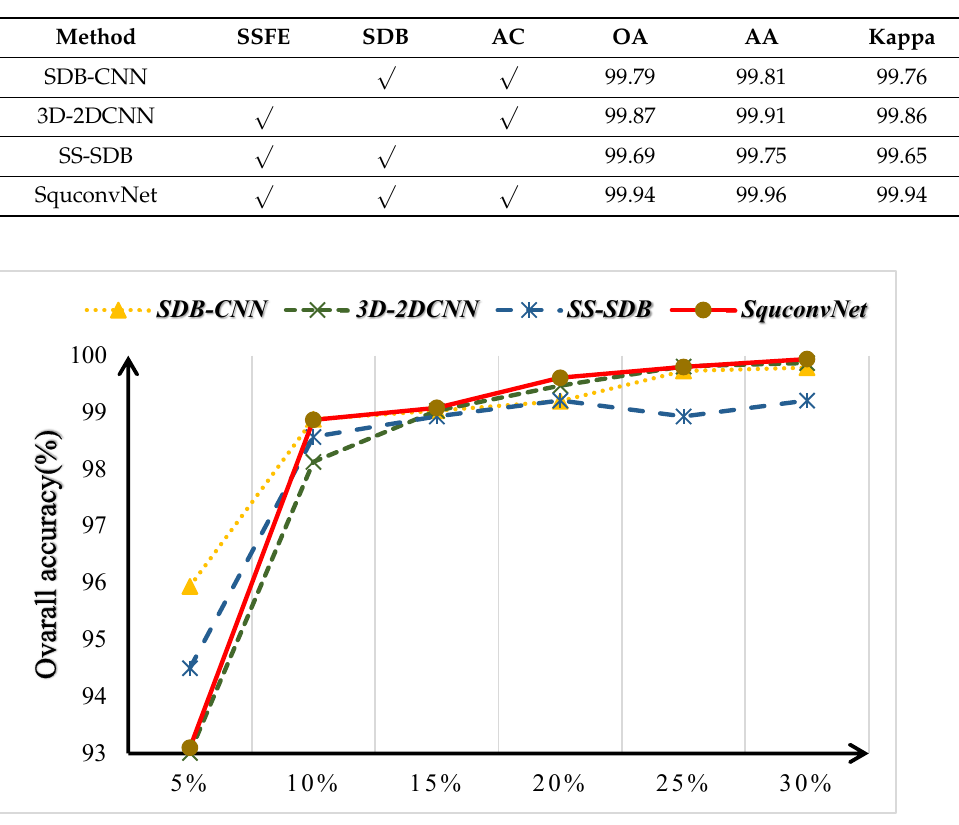
Table 8. Ablation analysis of the proposed methods on the IP dataset with 30% labeled samples.